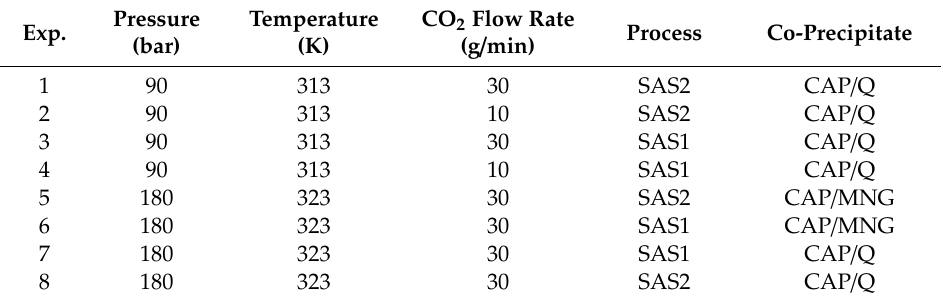
Table 1. Summary of supercritical antisolvent process (SAS) experiments carried out.